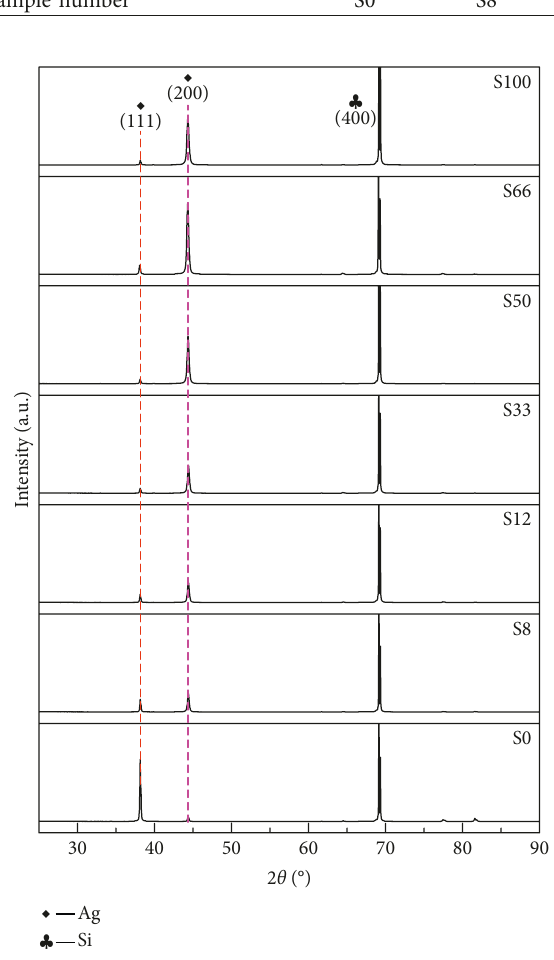
Figure 1: X-ray diffraction patterns (XRD) of silver thin films (S0, S8, S12, S33, S50, S66, and